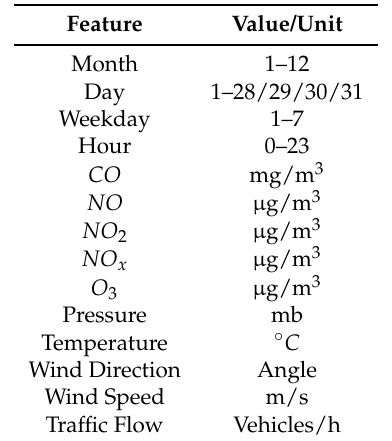
Table 1. Features used for training the